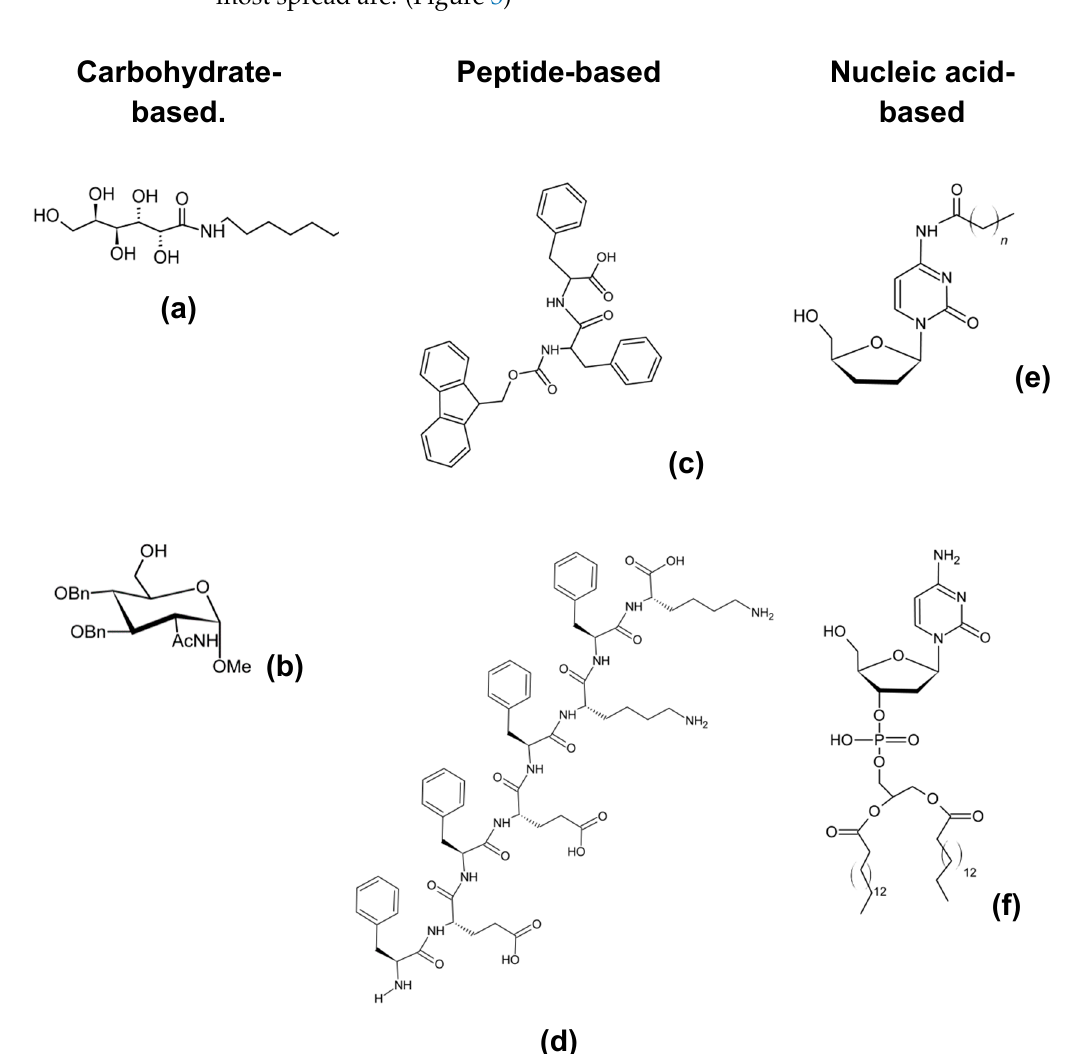
Figure 3. Examples of low-molecular-weight gelators (LMWG) structures. LMWG are either carbohydrate-based, such as ( a ) N-heptylgalactonamide or ( b ) N-acetyl glucosamine, or they can be peptide-based, such as ( c ) FmocFF or ( d ) FEFEFKFK peptide. Alternatively, they can be nucleic acid-based such as ( e ) N-acyl cytidine derivative or ( f ) Nucleotide lipid (diC16dC).